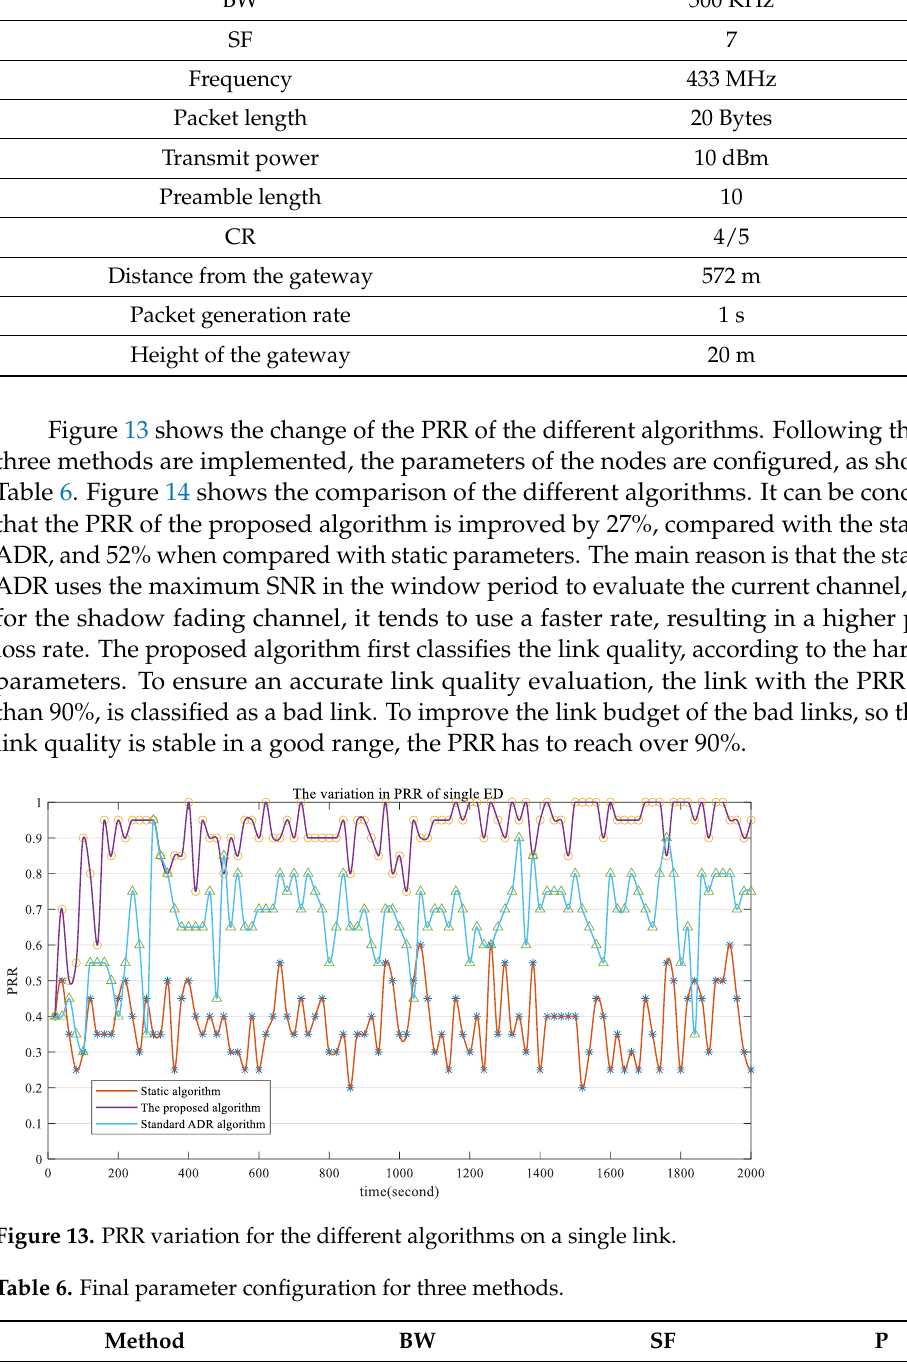
Table 5. Single ED initial parameter configuration.